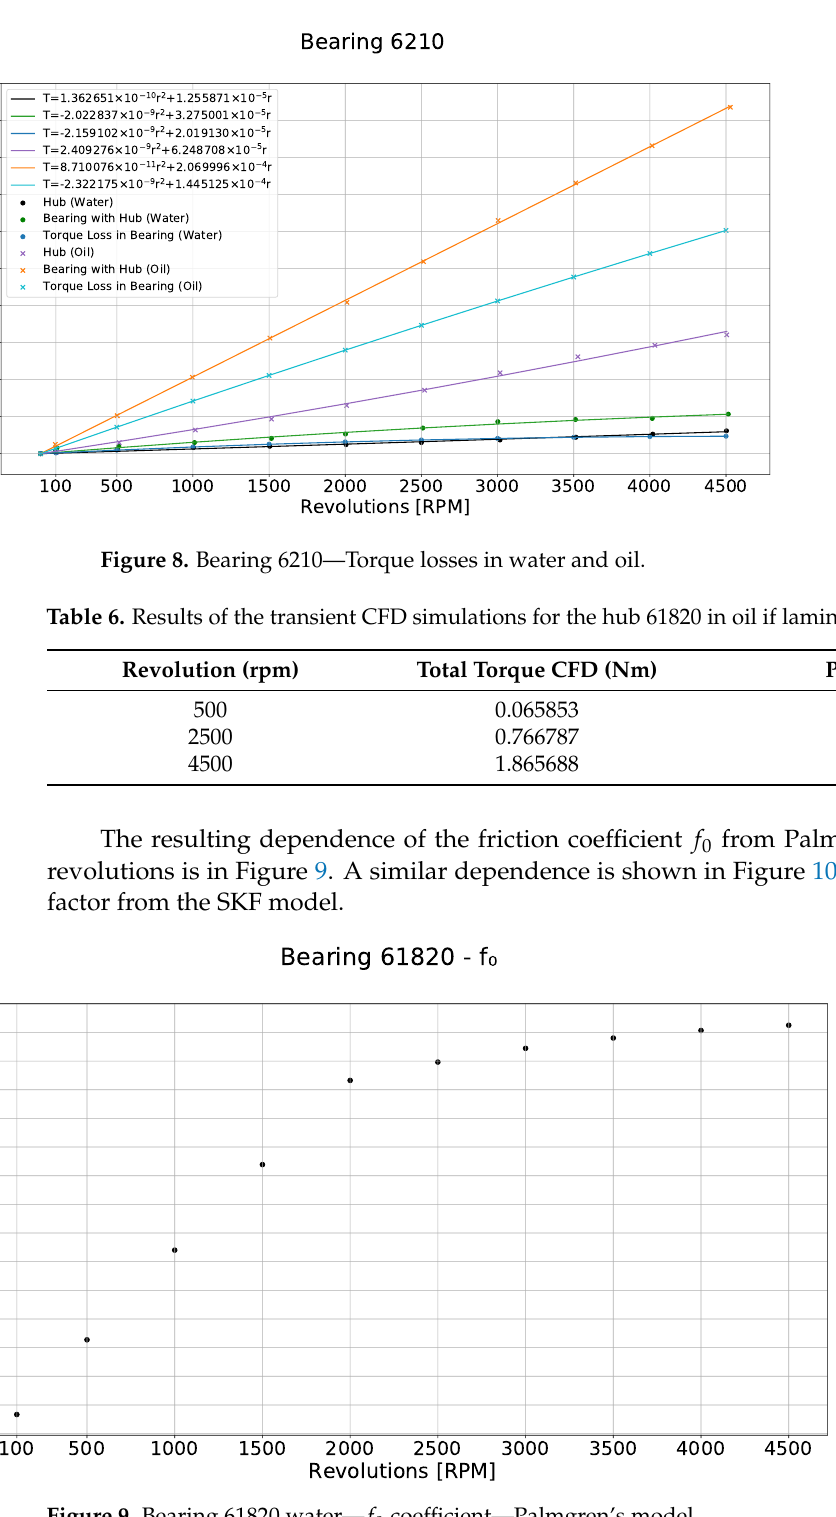
Figure 9. Bearing 61820 water— f 0 coefficient—Palmgren’s